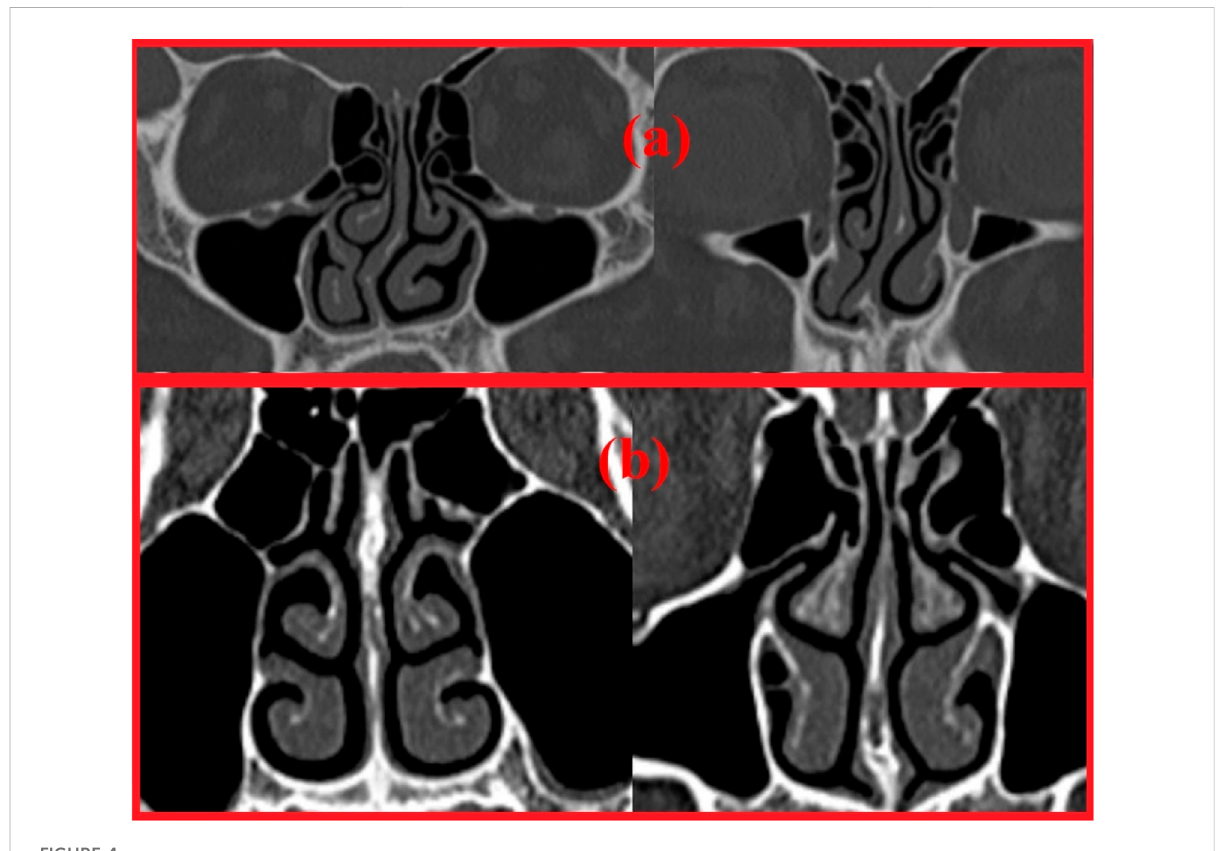
FIGURE 4 Coronal section showing (A) Deviated septum in P01 (B) Healthy nasal cavity in